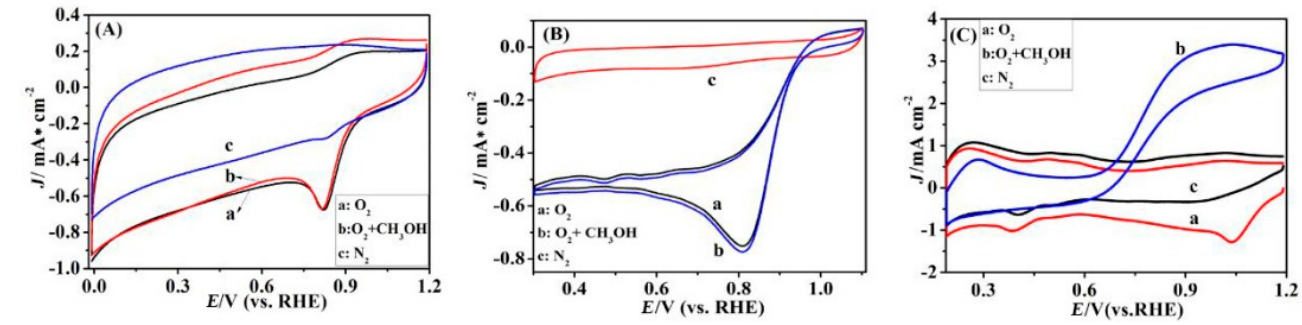
Figure 9. CVs in N 2 /O 2 -saturated and O 2 -saturated 0.1 M KOH/0.1 M HClO 4 upon the addition of CH 3 OH (10 vol%) for ( A ) MoS 2 /C in 0.1 M KOH and ( B ) MoS 2 /C in 0.1 M HClO 4 and ( C ) Pt/C in 0.1 M KOH. Scan rate: 30 mV s − 1 .